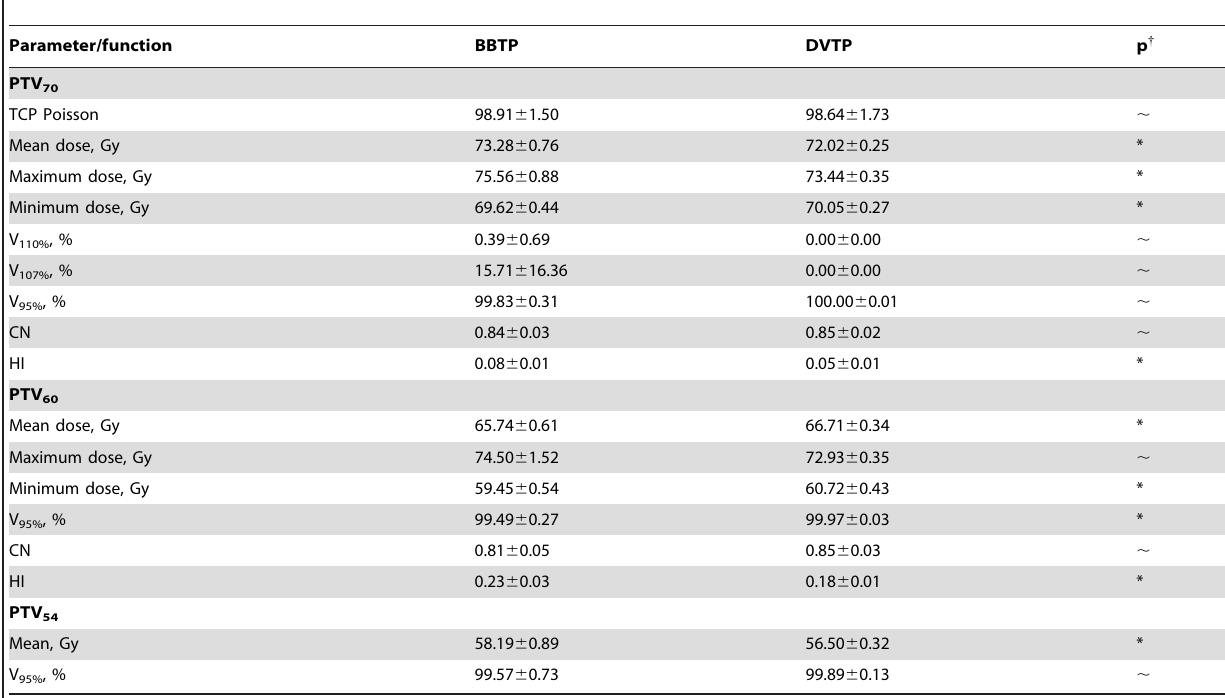
Table 4. Summary of biological and physical evaluation results for targets averaged over 10 early stage NPC patients.